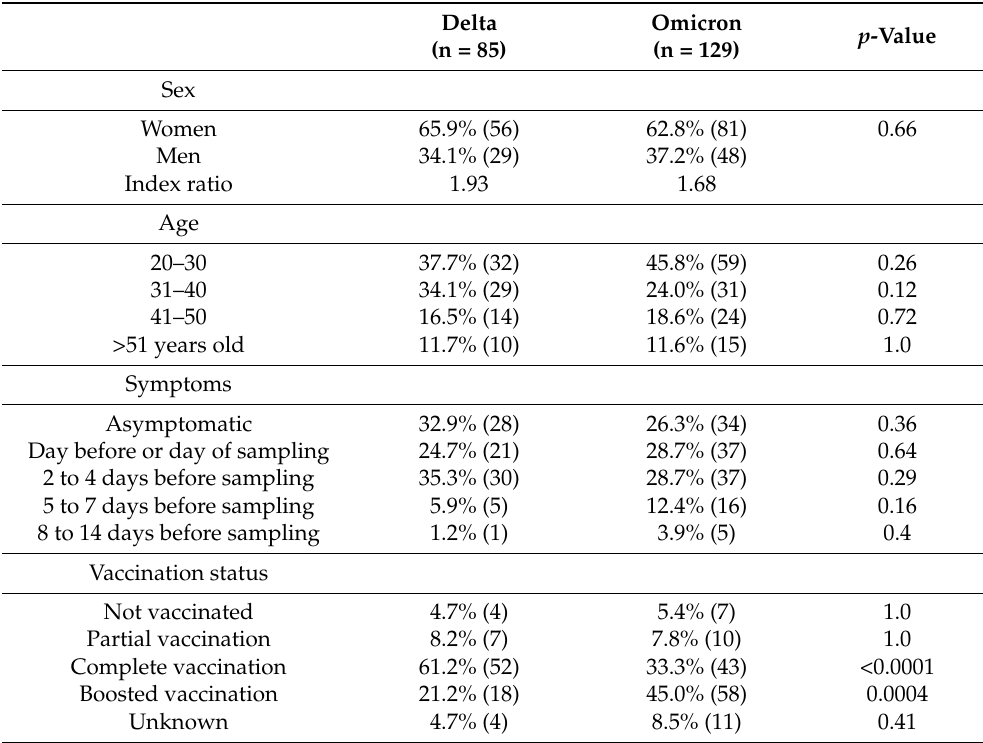
Table 1. Demographic